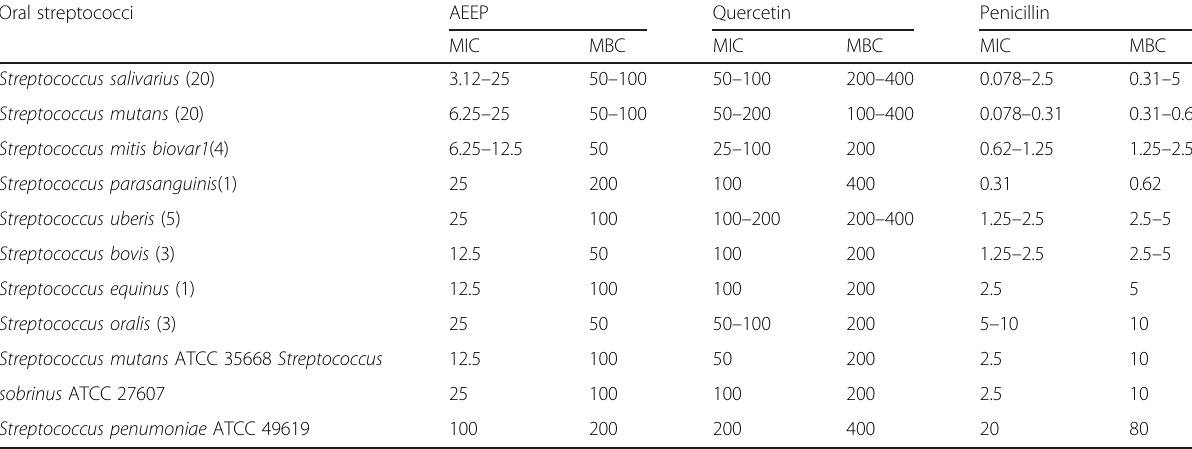
Table 1 The Minimum Inhibitory Concentration (MIC) values of samples against oral Streptococci (values in μ g/ml) Oral streptococci AEEP Quercetin